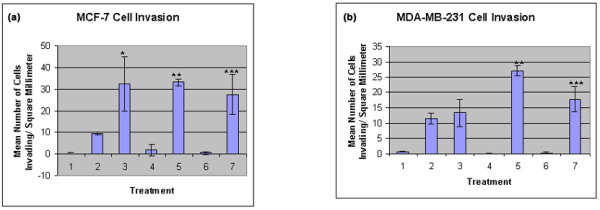
The effects of monocyte cells and CM on the invasive potential of breast adenocarcinoma cells. Graphs showing an increase in the number of (a) MCF-7 and (b) MDA-MB-231 cells that migrated through matrigel-coated membranes in response to monocyte cell CM. The following conditions were used in the lower chamber: 1, serum-free media; 2, 10% FBS in serum-free media; 3, THP-1 cell-conditioned media; 4, (a) 5 × 104 MCF-7 cells, (b) 5 × 104 MDA-MB-231 cells; 5, 5 × 104 THP-1 cells; 6, (a) 10 × 104 MCF-7 cells, (b) 10 × 104 MDA-MB-231 cells; 7, 10 × 104 THP-1 cells. *p < 0.05 compared to condition 2; **p < 0.05 compared to condition 4; ***p < 0.05 compared to condition 6. The values are the means of three experiments and the error bars are the standard error of the mean.